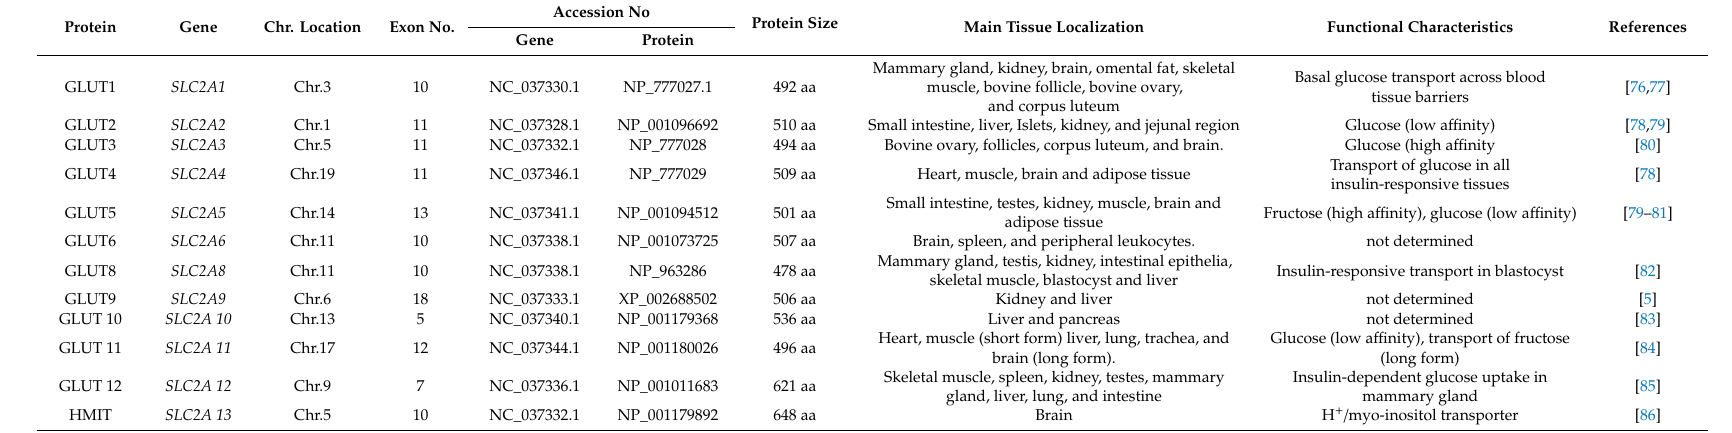
Table 2. Genomic information, tissue localization, and functional characteristics of facilitative glucose transporter (GLUTs) family members.